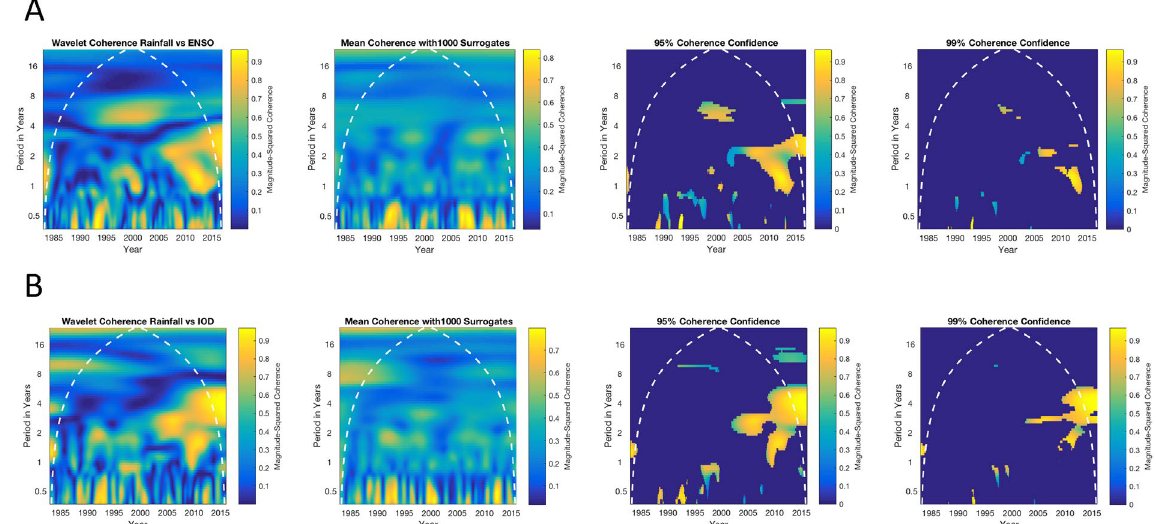
Figure 5. El Nino Southern Oscillation (ENSO) and Indian Ocean Dipole (IOD) relationship to spatially averaged rainfall. With rigorous statistical confidence bounds, there is a coherency between these indices and the Ugandan rainfall, but only in recent years, and only for relatively short periods from 1–4 years. ( A ) Wavelet coherency between spatially averaged and filtered rainfall, with the ENSO index interpolated from monthly to daily values, and filtered identically as rainfall data. The second panel reflects the mean of 1000 surrogate coherency calculations, from which 95% (third panel) and 99% (fourth panel) confidence limits reveal only the regions that met these significance criteria. The cone of influence, delimiting where edge effects substantially confound the analysis, is indicated by the white dotted line. ( B ) Identical calculations for the IOD index. The most significant coherencies between ENSO and IOD occurs during the most recent 10 years, with periods from 1–4